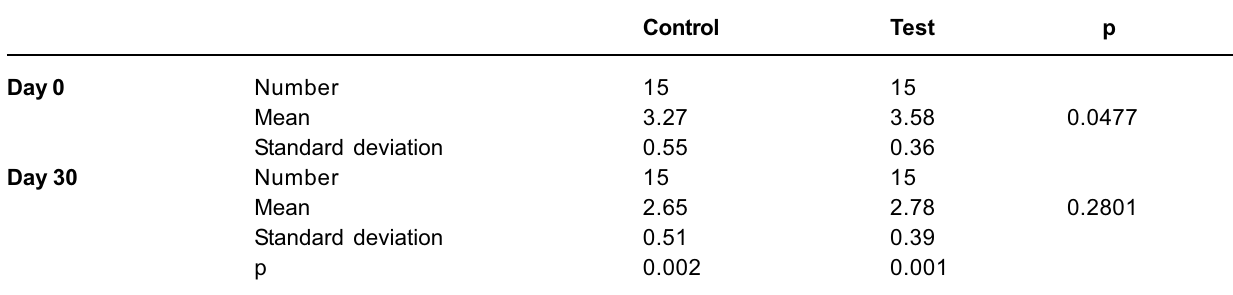
TABLE 3- Plaque index (PI) means and standard deviation on day 0 and day 30 for the control and test